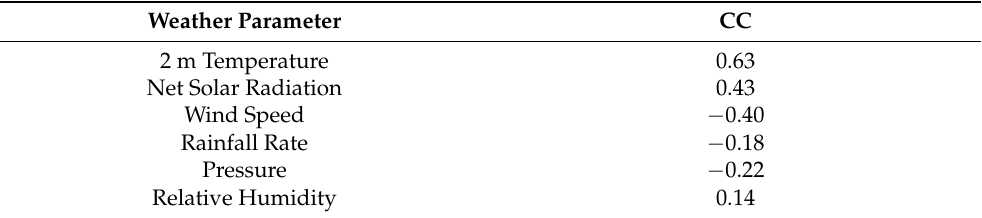
Figure 7. As in Figure 4, for other weather parameters; ( a ) rainfall rate; ( b ) pressure; ( c ) relative humidity. Table 1. Correlation Coefficient (CC) between electricity load and various weather